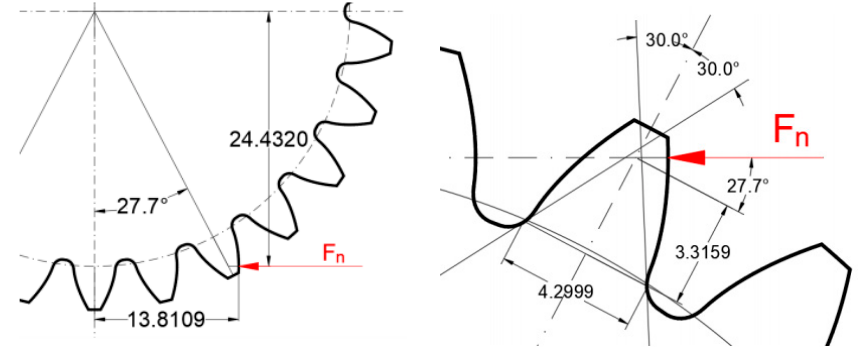
Figure 3. Determination of the most critical section.